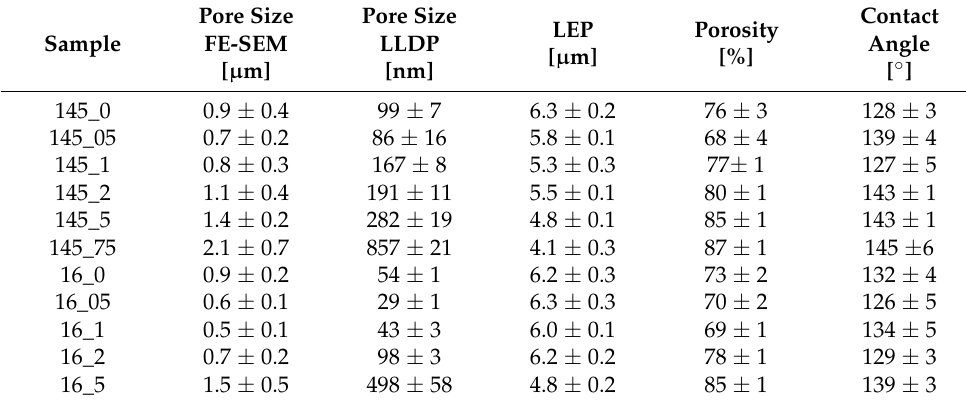
Table 4. Main properties of 14.5 wt % and 16 wt % PVDF membranes.